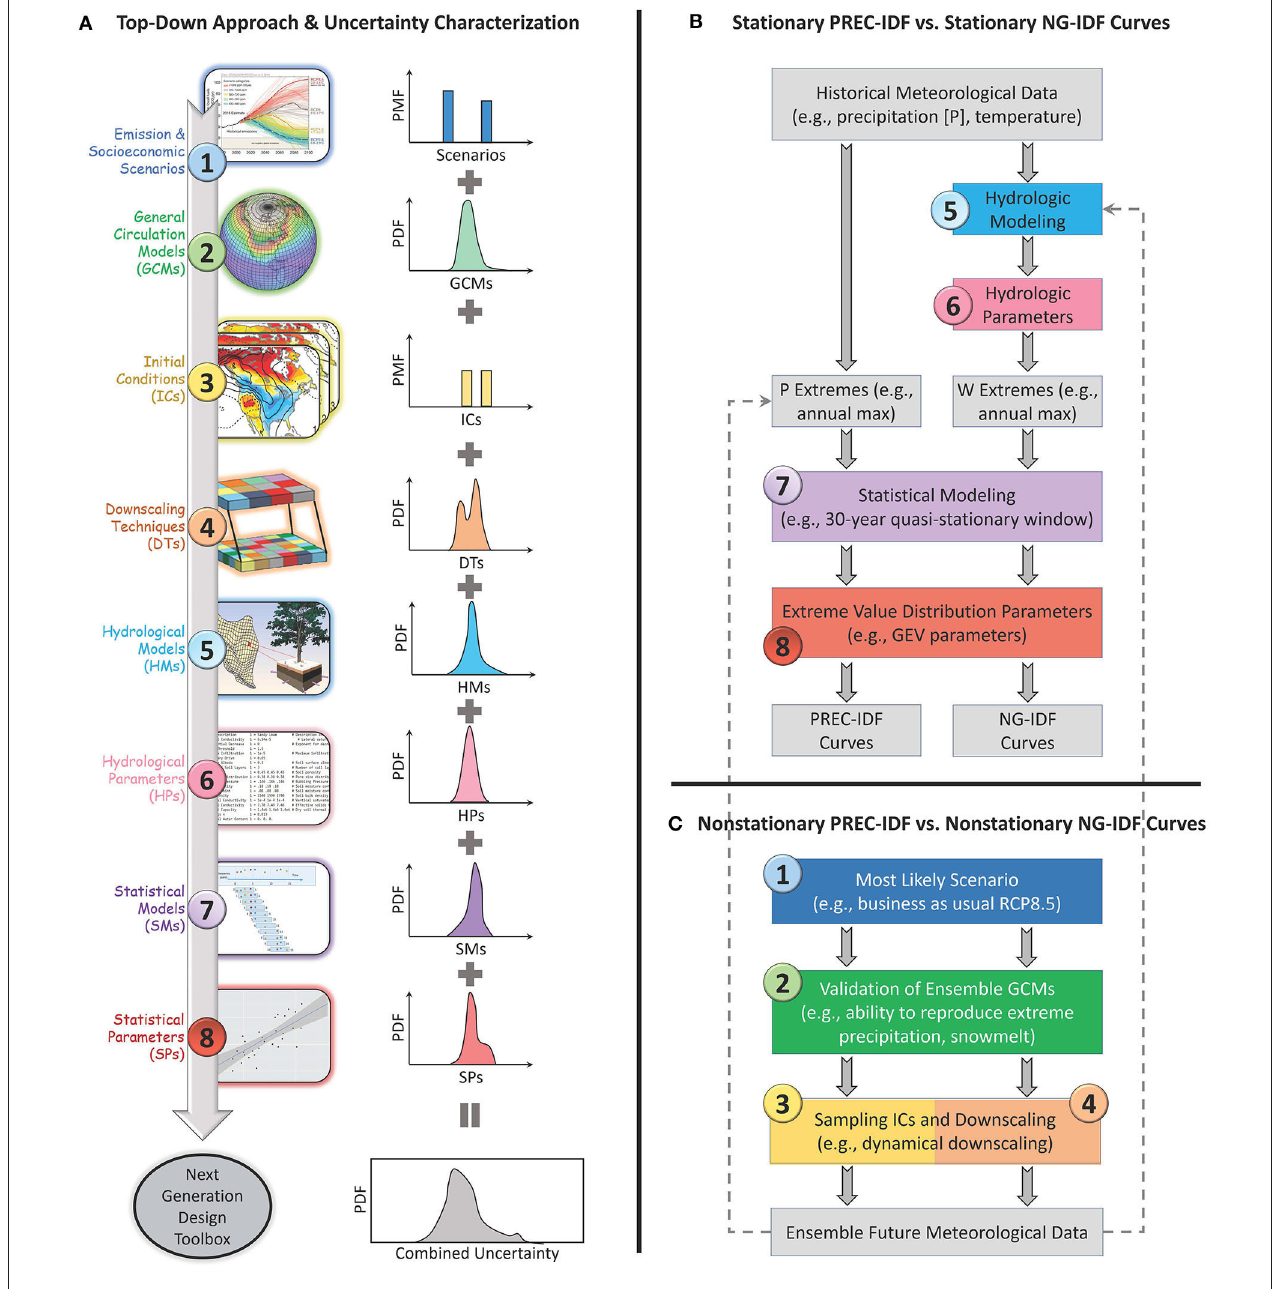
FIGURE 1 | (A) Top-down approach to develop nonstationary next-generation hydrologic design toolbox. To make the projection actionable to engineers, deliberate approaches are necessary to characterize and reduce uncertainties in each step. The final nonstationary design toolbox should be probabilistic (i.e., projections of the most likely, the least, and worst cases) and adapted to the standard risk management design framework. (B) Developing stationary PREC-IDF and NG-IDF curves following the top-down approach. (C) Developing nonstationary PREC-IDF and NG-IDF curves following the top-down